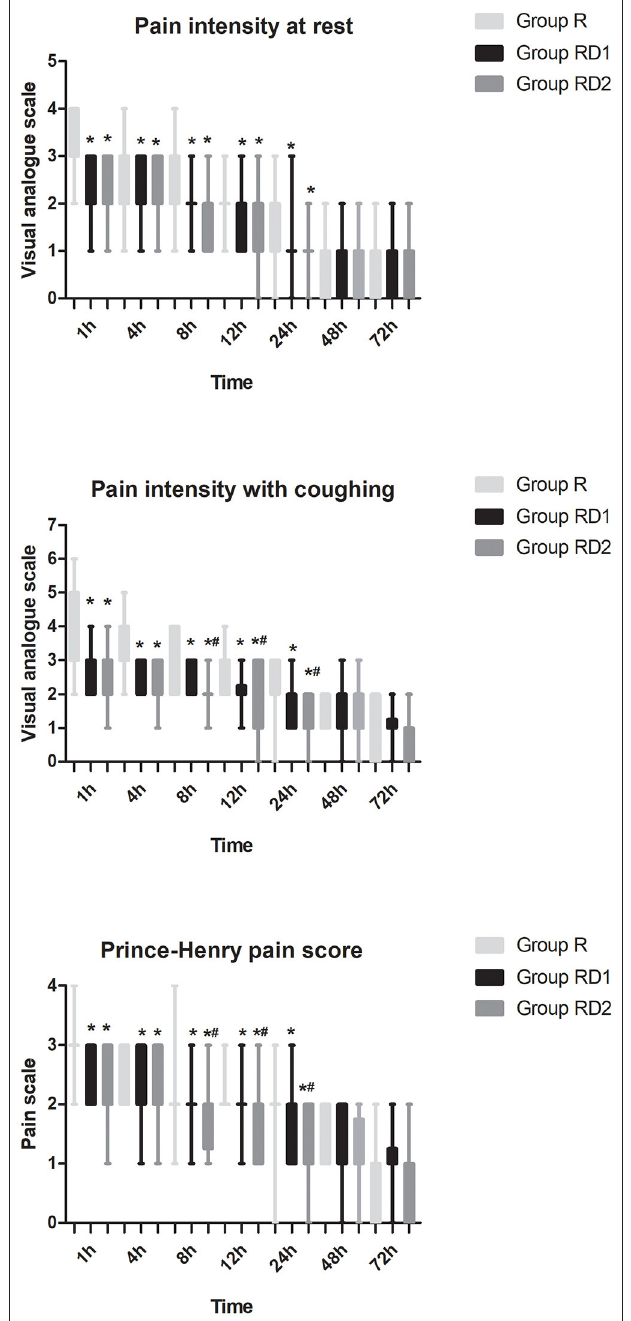
FIGURE 3 | Post-operative pain intensity (at rest and with coughing and Prince Henry pain score) during the first 72h after surgery among the three groups. * P < 0.05 vs. group R, # P < 0.05 vs. group RD1.